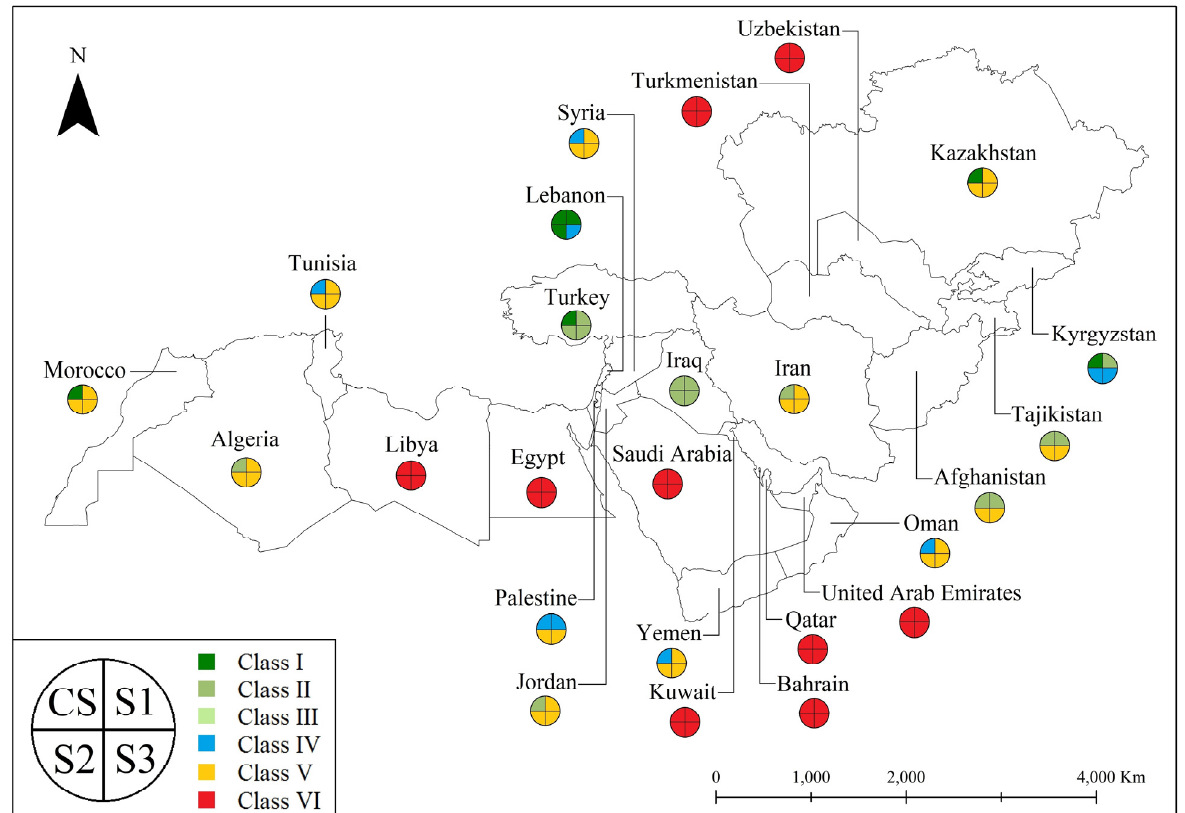
Figure 2. MENA and Central Asian countries, with their current renewable water exploitation rate. The figure also shows the three farming scenarios’ water requirement classifications. CS is the current situation, S1, S2, and S3 are the classification for scenarios 1, 2, and 3 in each country, respectively.